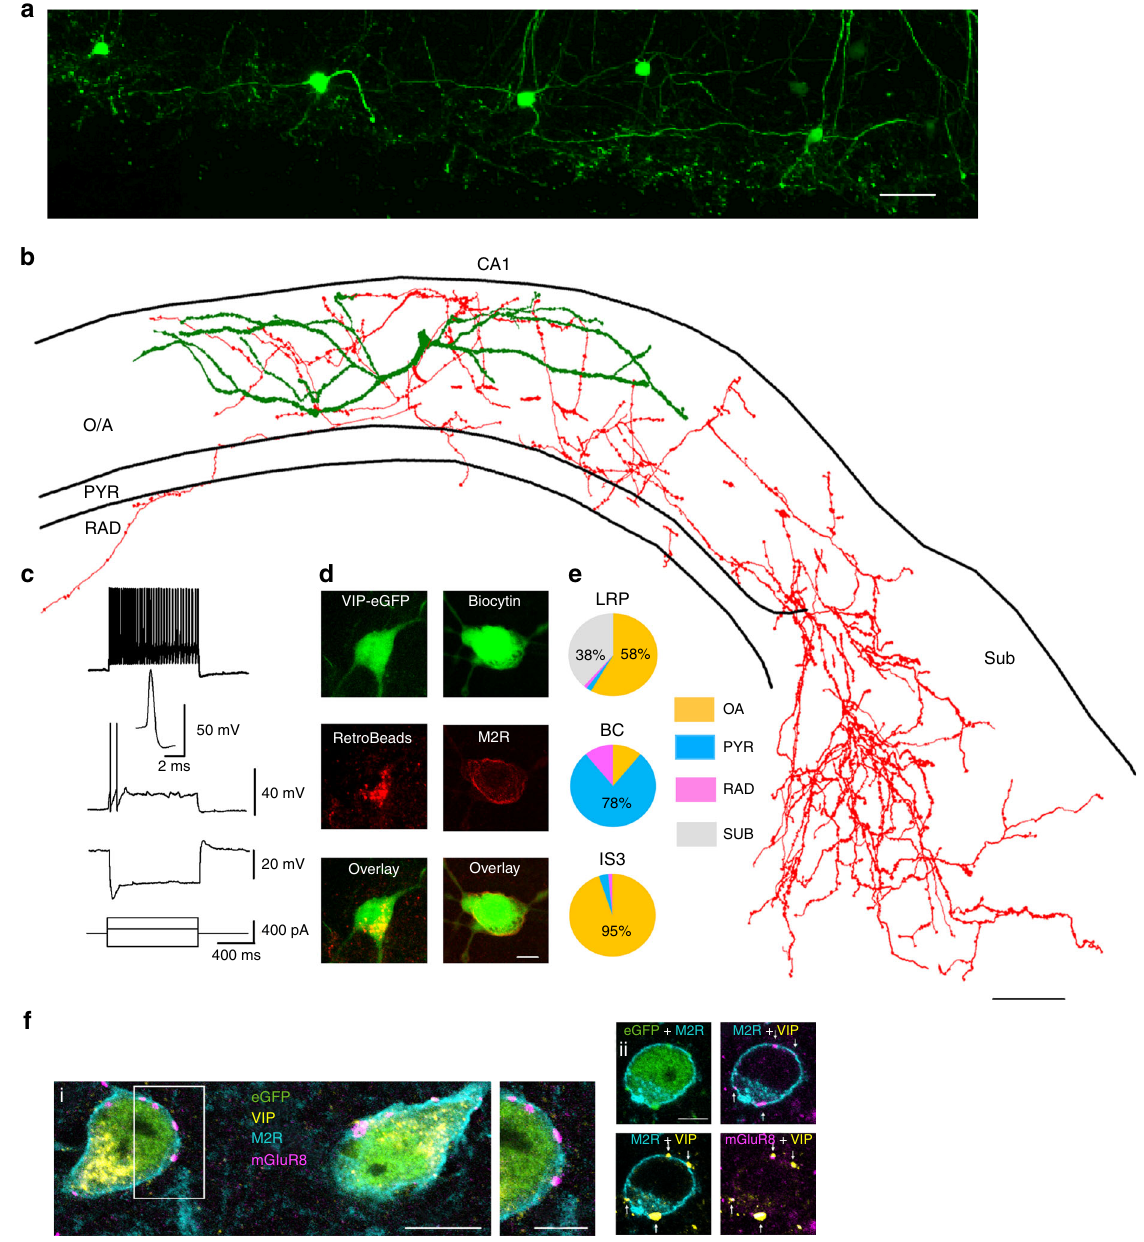
Fig. 1 Identi fi cation of VIP-LRPs in the VIP-eGFP mouse. a Two-photon image (maximal projection of a z-stack of 200 µ m height) of the CA1 area from an acute hippocampal slice (300 µ m) of a VIP-eGFP mouse showing the location of GFP cell bodies, axons and dendrites in the O/A area of CA1. Scale bar: 100 µ m. b Reconstruction (the axon is shown in red, the dendrites are shown in green) of a VIP-LRP cell that was recorded and fi lled with biocytin in a slice obtained from a VIP-eGFP mouse. Scale bar: 100 µ m. c Representative voltage responses of a VIP-LRP to hyperpolarizing ( − 240 pA), and depolarizing ( + 80 pA and + 280 pA) current injections, with an inset illustrating the fi rst spike evoked by + 80-pA current pulse. d Confocal images showing RetroBeads labelling of a VIP-LRP soma (left) after injection in subiculum and immunoreactivity for M2R in a VIP-positive neuron labelled with biocytin (single focal plane, right). Scale bar: 10 µ m. e Pie charts illustrating the mean axonal distribution in different layers (based on axon length obtained following reconstruction in Neurolucida) for groups of cells corresponding to three different cell types: VIP-LRP ( n = 10), VIP-BC ( n = 5) and IS3 cell ( n = 6). OA oriens-alveus, PYR stratum pyramidale, RAD stratum radiatum, SUB subiculum. No axon was detected within stratum lacunosum moleculare (LM) for the three cell types. Statistically signi fi cant differences in the axon distribution between VIP-LRP and VIP-BCs, VIP-LRP and IS3, and VIP-BCs and IS3 at ** p < 0.01, one-way ANOVA followed by Tukey ’ s test. f VIP-LRP cells, identi fi ed by somato-dendritic membrane M2R immunoreactivity (blue), are innervated by terminals rich in presynaptic mGluR8 (purple). Single optical slices (0.45 mm thick) of confocal images of quadruple immunoreactions as indicated: i, right, framed area at higher magni fi cation; ii, four VIP + terminals (arrows) show mGluR8 immunoreactivity. Scale bars: 10 µ m (left), 5 µ m (middle), 5 µ m